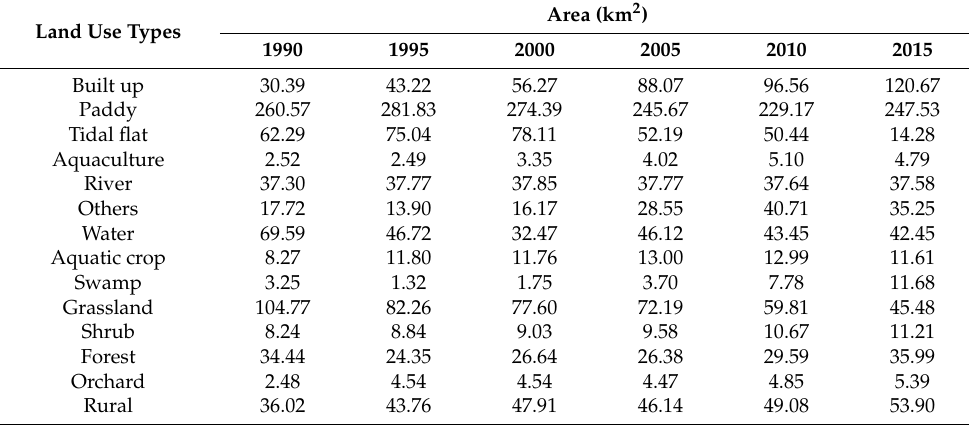
Table 6. Area of land use types in Phnom Penh from 1990 to 2015. Land Use